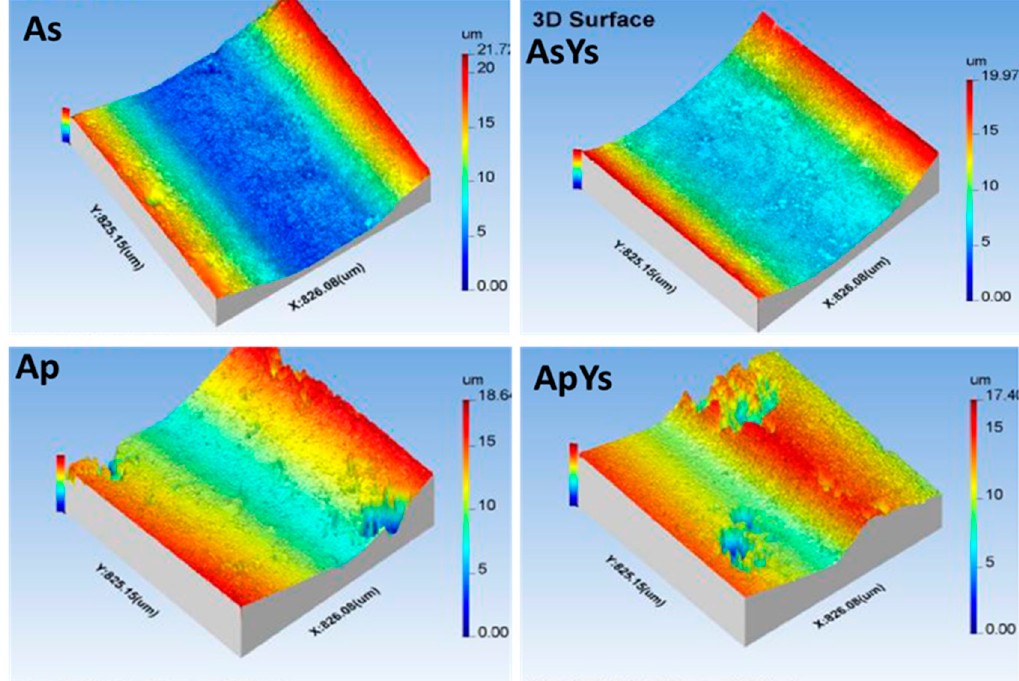
Figure 10 . Three-dimensional (3-D)-optical profilometer images of coatings As, AsYs, Ap, and ApYs.